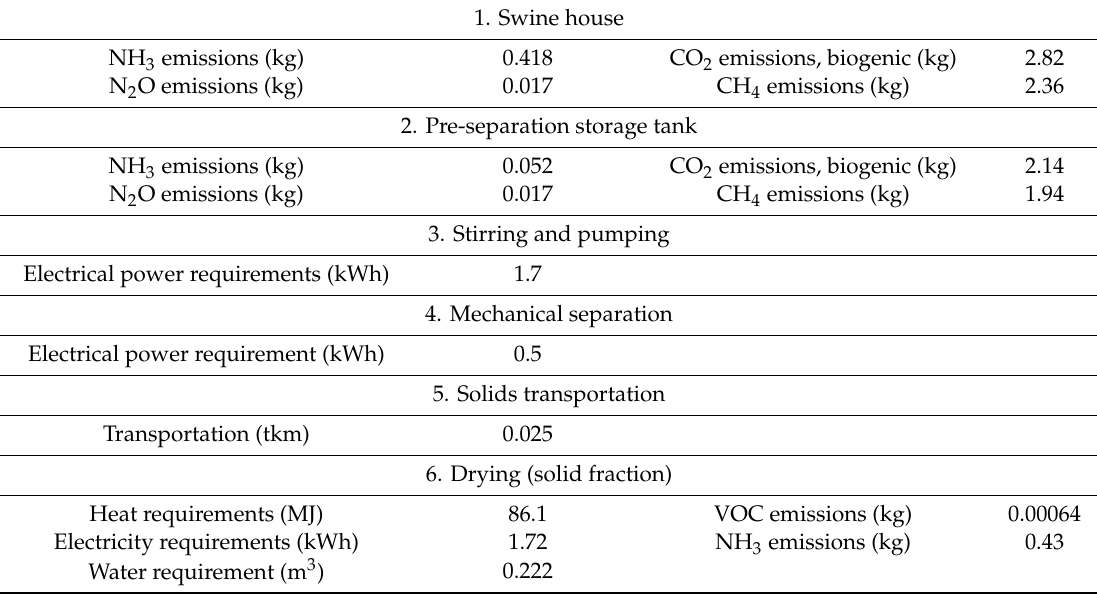
Table 5. Summary of emissions, energy, and transportation requirements as well as an avoided burden for the functional